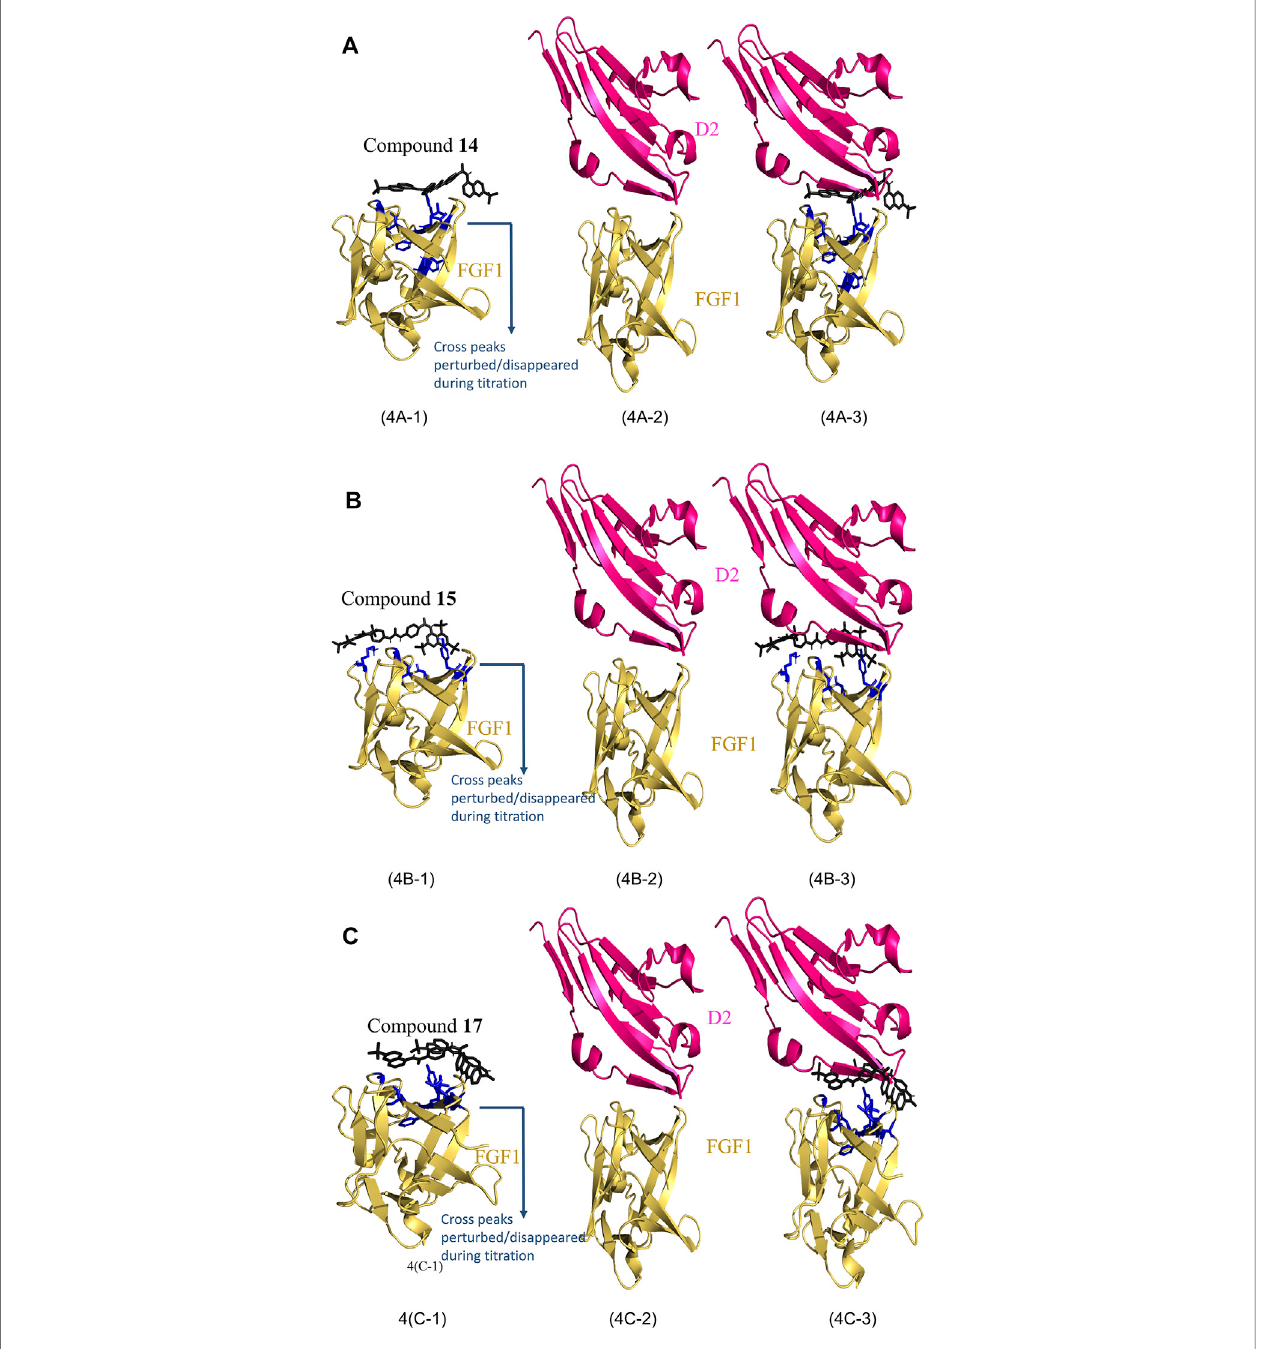
FIGURE 4 | HADDOCK results of FGF1 with the fi ve compounds. (4A) : (4A-1) Calculated HADDOCK of Compound 14 (black) complex with FGF1 (Yellow) with AIRpainted inblue, (4A-2) X-raycrystallographicstructureofFGF1andD2(PDBID:3CU1). (4A-3) overlapof (4A-1) and (4A-2) . (4B) : (4B-1) CalculatedHADDOCKof Compound 15 (black) complex with FGF1 (Yellow) with AIR painted in blue, (4B-2) X-ray crystallographic structure of FGF1 and D2 (PDB ID: 3CU1). (4B-3) overlap of (4B-1) and (4B-2) . (4C) : (4C-1) Calculated HADDOCK of Compound 17 (black) complex with FGF1 (Yellow) with AIR painted in blue, (4C-2) X-ray crystallographic structure ofFGF1 and D2 (PDB ID: 3CU1). (4C-3) overlap of (4C-1) and (4C-2) . (4D) : (4D-1) Calculated HADDOCK ofCompound 18 (black) complex with FGF1 (Yellow) with AIR painted in blue, (4D-2) X-ray crystallographic structure of FGF1 and D2 (PDB ID: 3CU1). (4D-3) overlap of (4D-1) and (4D-2) . (4E) : (4E-1) Calculated HADDOCK of Compound 21 (black) complex with FGF1 (Yellow) with AIR painted in blue, (4E-2) X-ray crystallographic structure of FGF1 and D2 (PDB ID: 3CU1). (4E-3) overlap of (4E-1) and (4E-2) .